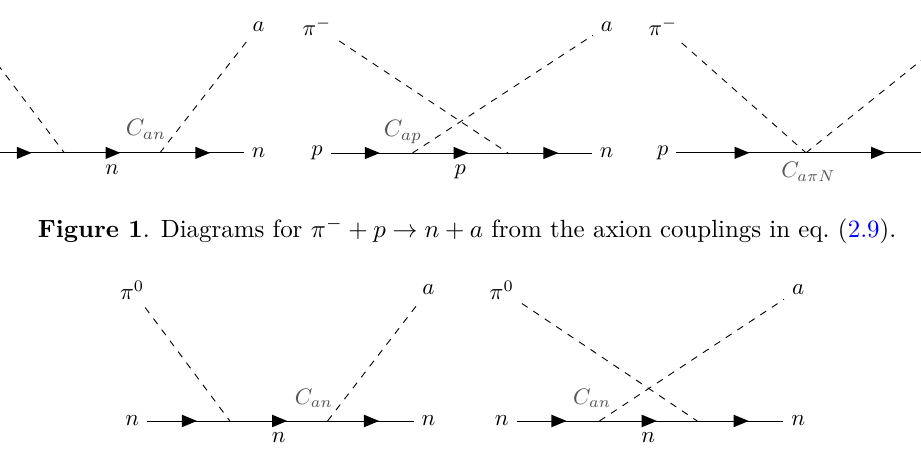
Figure 2 . Diagrams of axion production for the process π 0 + n → n + a